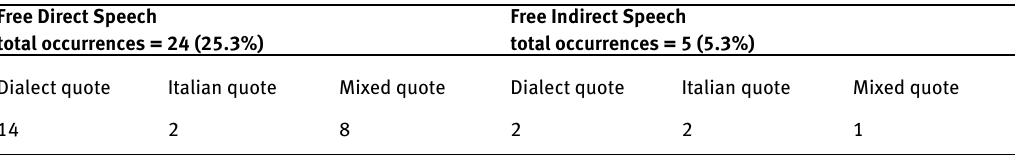
Table 3: Breakdown of FDS and FIS occurrences Free Direct